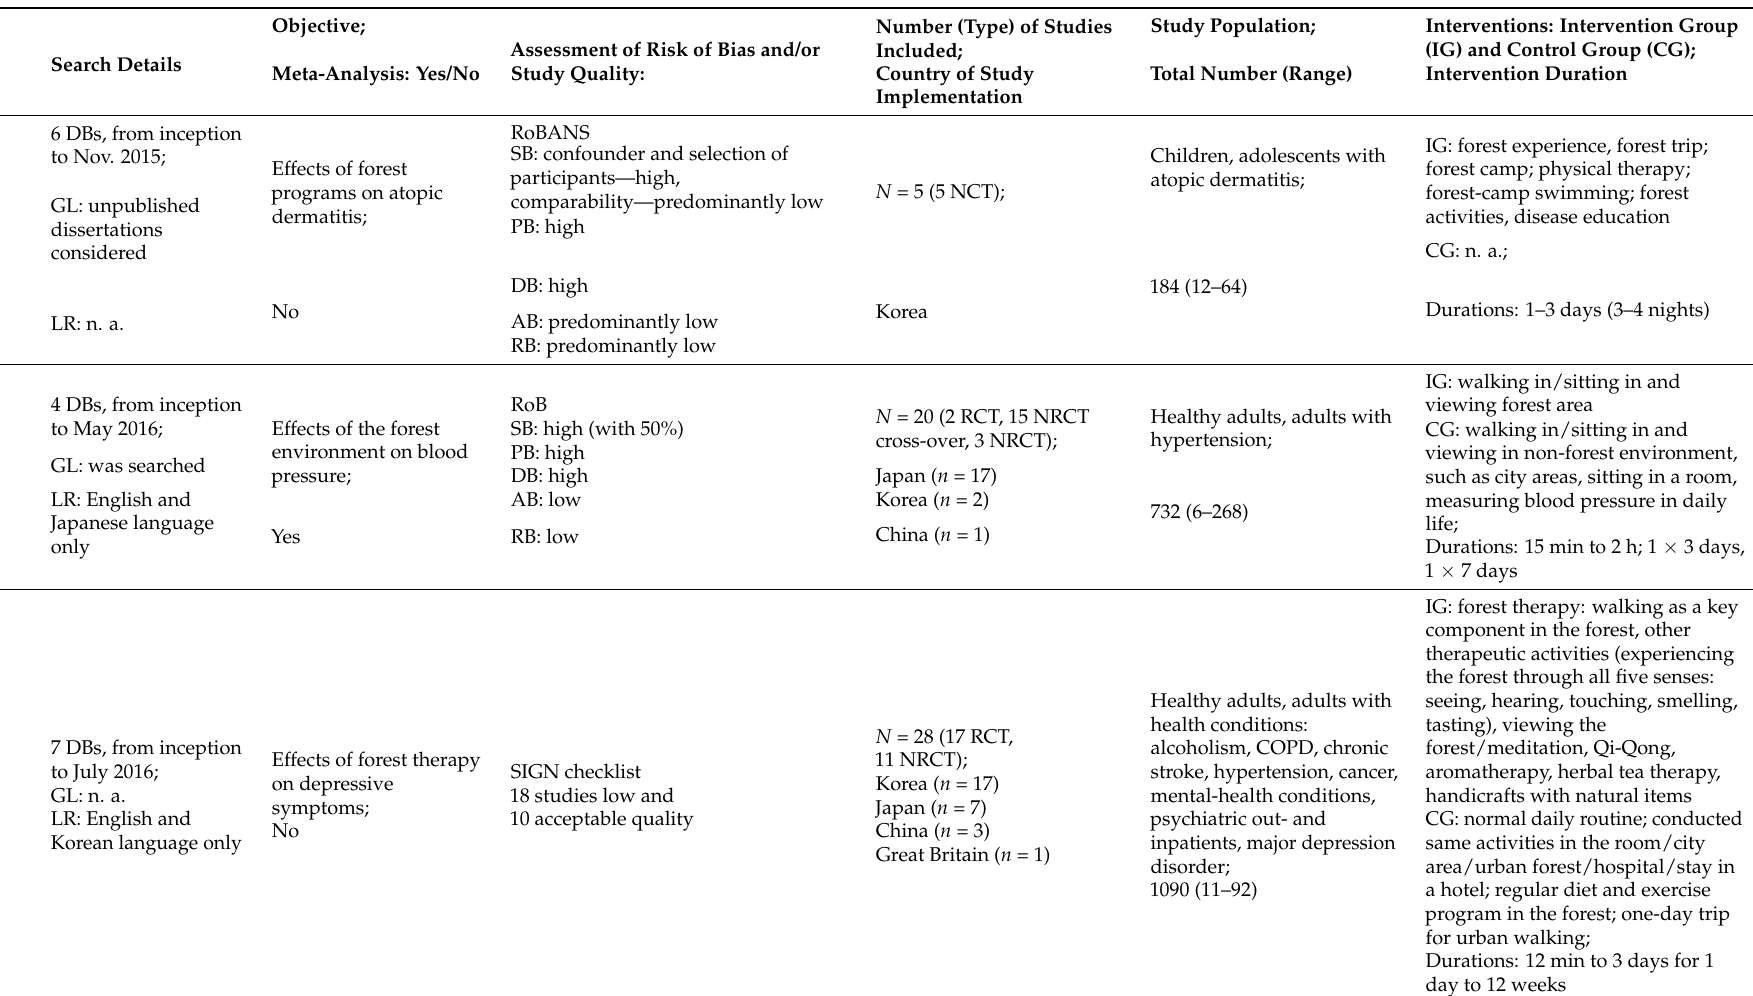
Table 1. Characteristics of included reviews and meta-analyses including key details of the covered primary